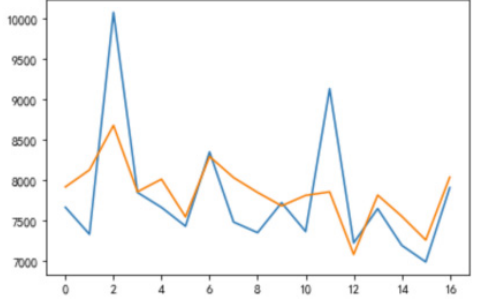
Figure 6. A320 fuel consumption forecast.